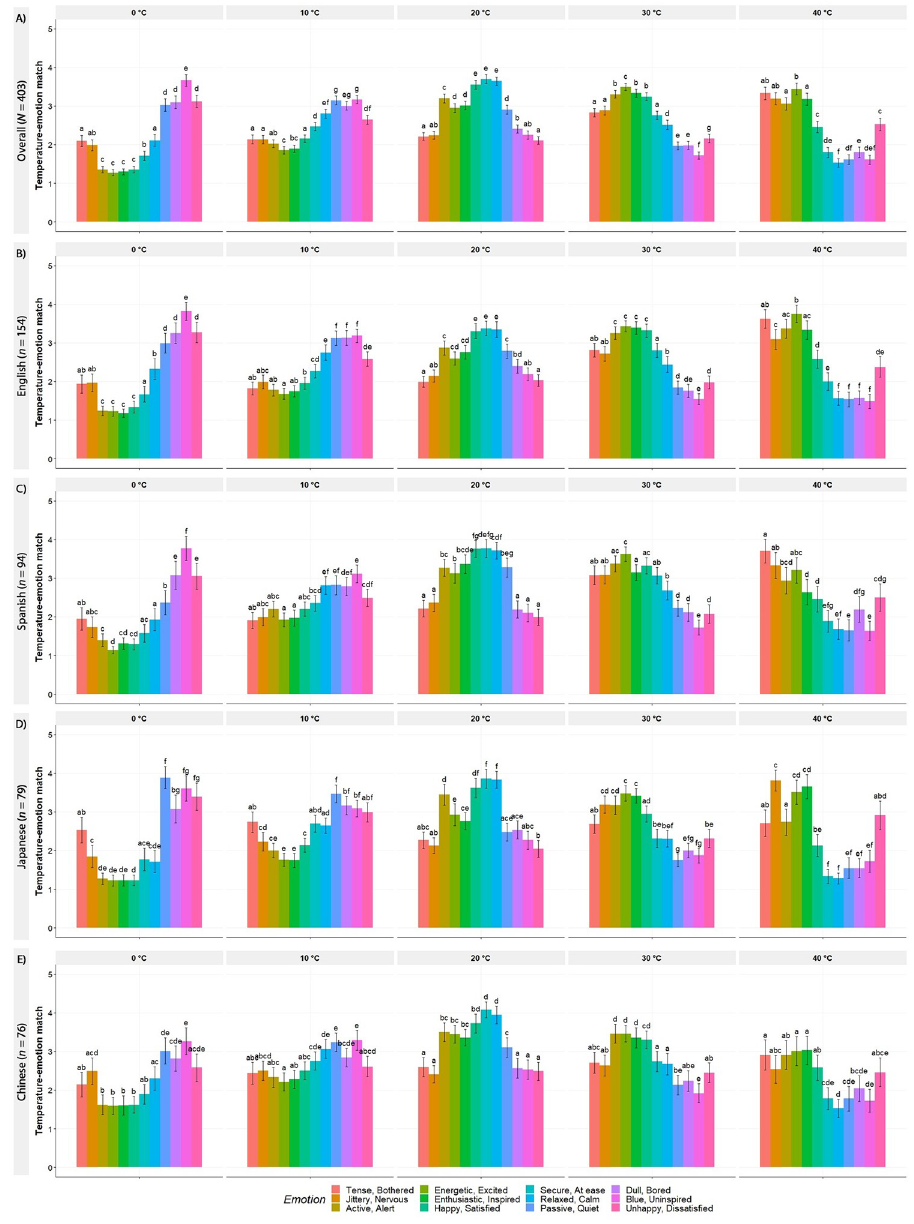
Fig 4. Mean ratings and Wilcoxon Signed Ranked test results for the temperature-emotion association ratings in Experiment 1. The y-axis is on a 1–5 scale, where 1 indicates the emotion and the temperature do not match well at all, and 5 indicates they match very well. The plots are divided into different blocks for each temperature (horizontally) within each language (vertically). The error bars represent the standard errors of the mean. The letters represent the different significance groups ( p < .05) within each temperature and language as per the Wilcoxon Signed Rank